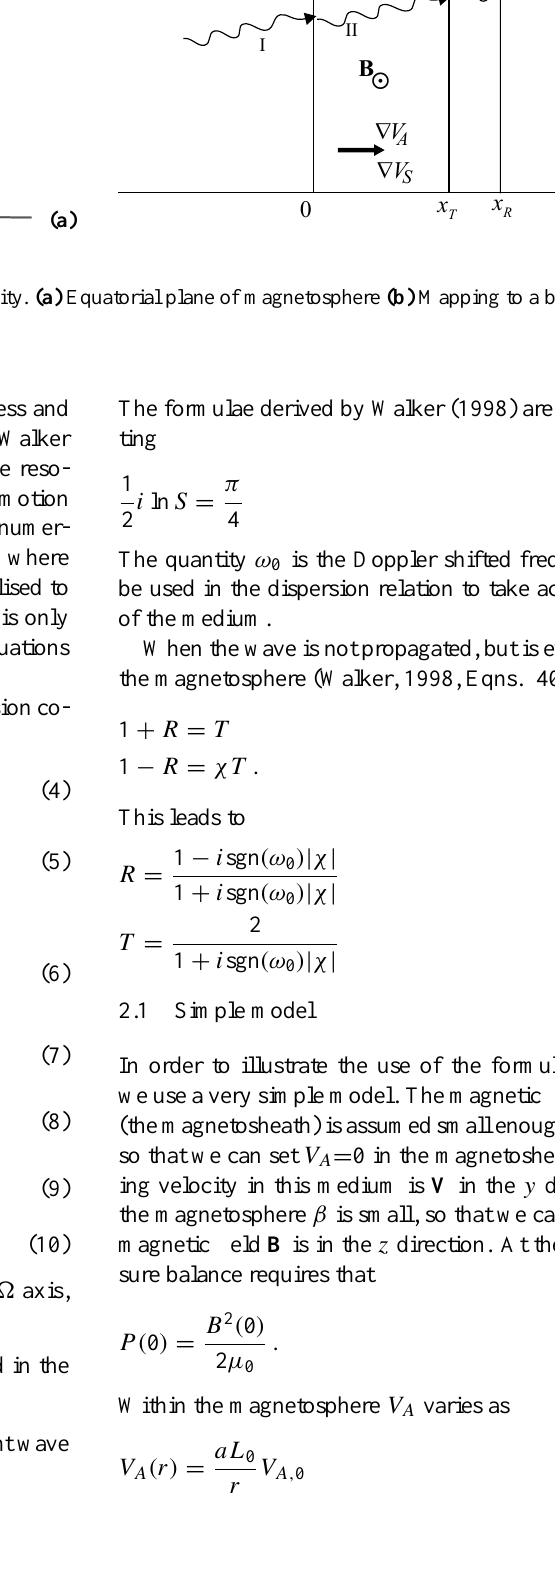
Fig. 1. Box model of the magneto- spheric waveguide or cavity. (a) Equa- torial plane of magnetosphere (b) Map- ping to a box model (see text for expla- nation)